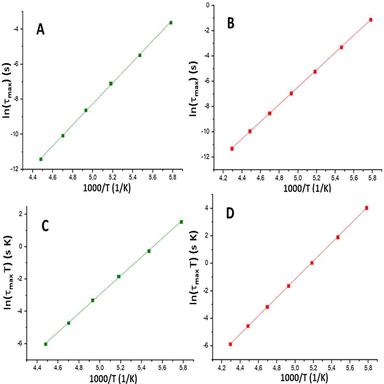
Arrhenius (up) and Eyring (down) plots relating the relaxation time, obtained from the maximum from loss peaks, with respect to the inverse of temperature for PCNMeiT (A, C) and PDCNiT (B, D).